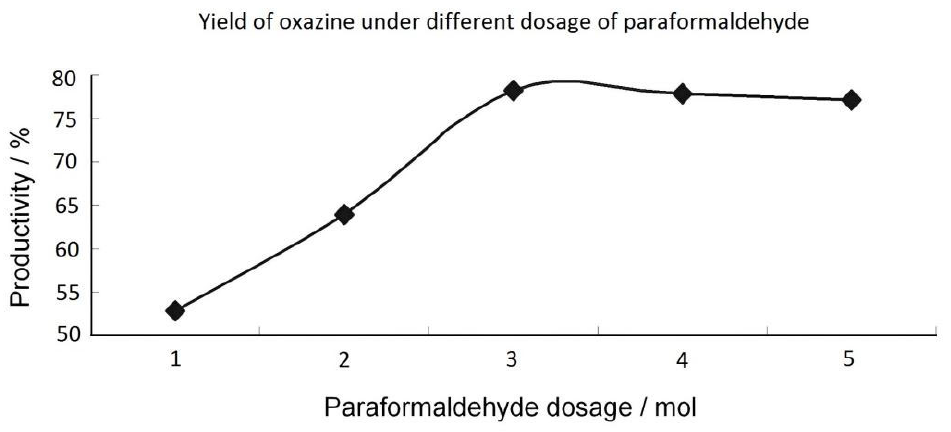
Figure 3. The product yield with the quantity of aldehydes.